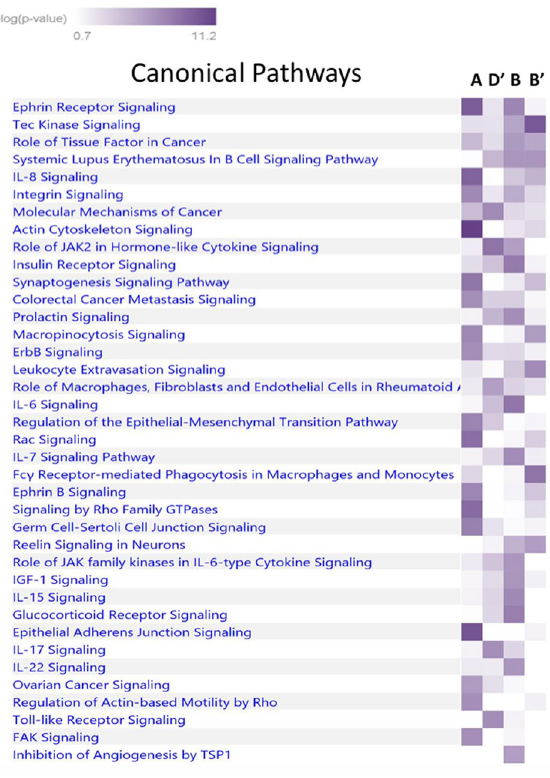
Figure 4. Comparative network analysis from Ingenuity Pathway Analysis. Comparison of case dominated clusters A, D,’ B, B’. All pathways significant p< 10 6 to 10 8